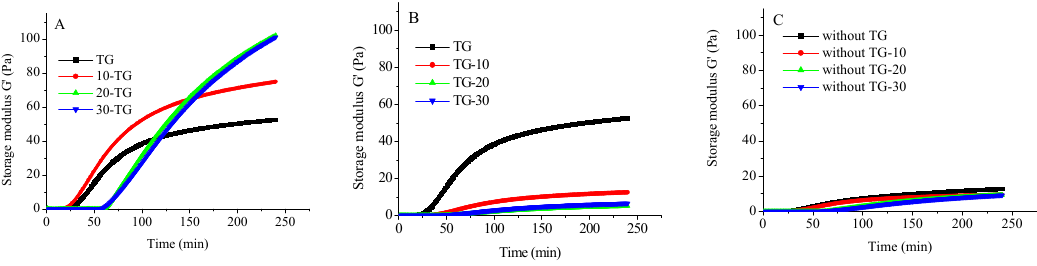
Figure 1. The evolution of the storage modulus as a function of time (( A ) Route 1; ( B ) Route 2; ( C ) Route 3 (without mTGase)).